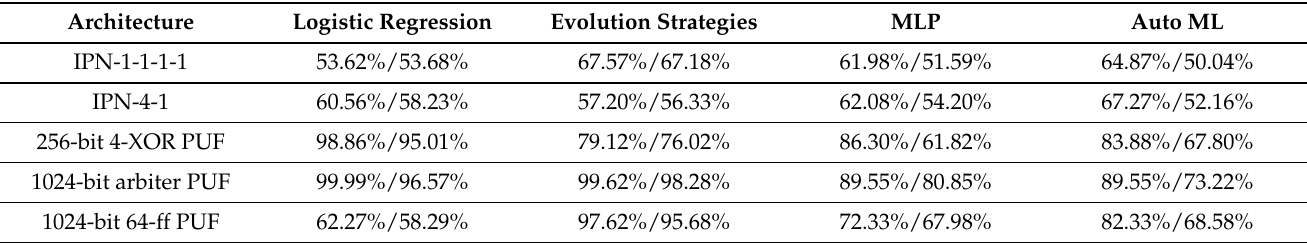
Table 4. Best prediction accuracy on different PUF architectures using machine learning algorithms out of 100 runs. Each cell contains simulated/implementation result.